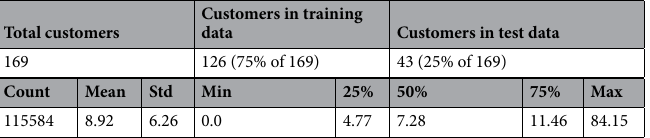
Table 2. Insights of the data set.